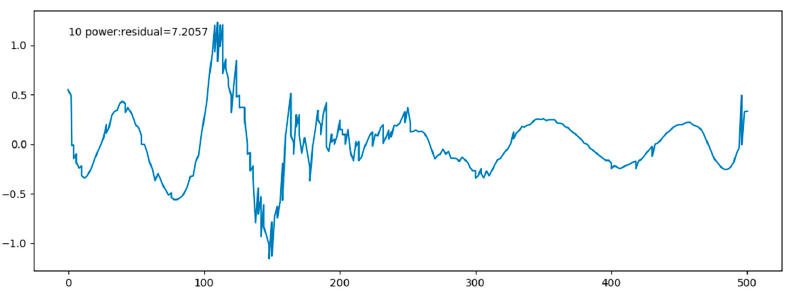
Figure 15. Residual plot.